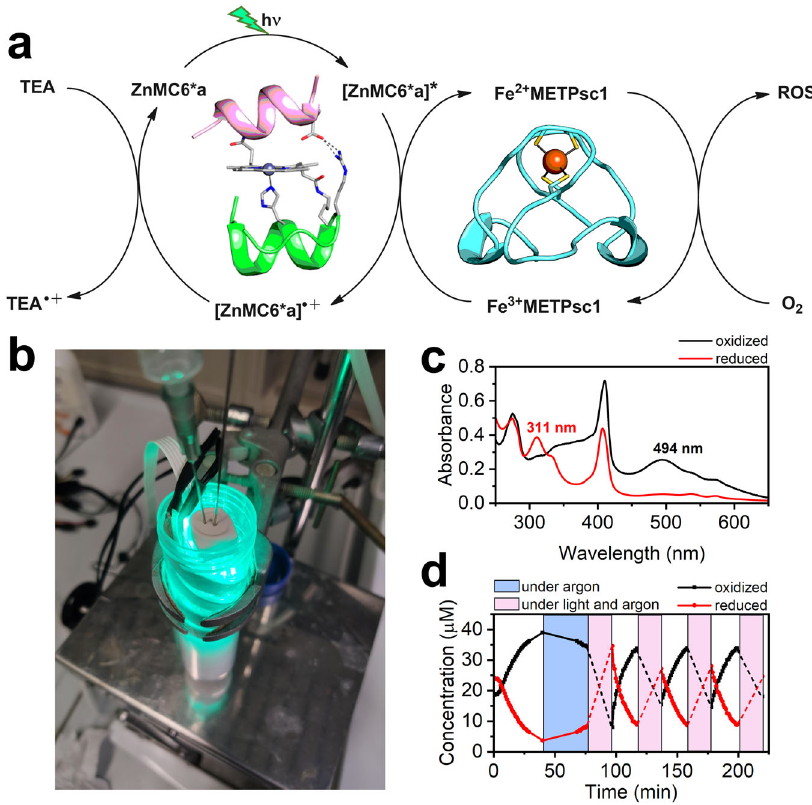
Fig. 7 | Photoinduced electron transfer from ZnMC6*a (5 µ M) to Fe 3+ METPsc1 (40 µ M). a Reaction scheme of the synthetic electron cascade. b experimental setupshowingtheLEDstripwrappedaroundtheUVcuvetteunderAratmosphere. c superimposed UV-Vis spectra of Fe 3+ METPsc1 (black trace) and Fe 2+ METPsc1 (red trace)inthepresenceofZnMC6*a(5 µ M)andtriethylamine(2mM). d redoxcycling